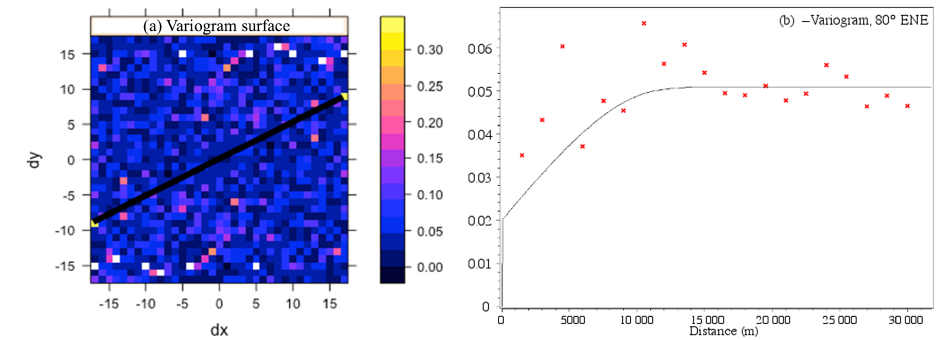
Figure 5. (a) Variogram surface of fault lengths in the PAFS, with a straight line showing the direction of the best spatial autocorrelation. At the center a pattern forms a shape of an ellipse, suggesting that the best correlations are observed in northeast–southwest direction. (b) Anisotropic variogram of fault lengths, which exhibits a good structure in east-northeast direction (80 ◦ ), and matches with a spherical model (black continuous line). So, these faults are optimally oriented in relation to the current stress in the PAFS ( σ 2). So, this anisotropic direction indicates that the spatial distribution of faults is mainly due to extensional stresses, and is consequently subject to deformation generated by the current stress field in the PAFS ( σ 2,